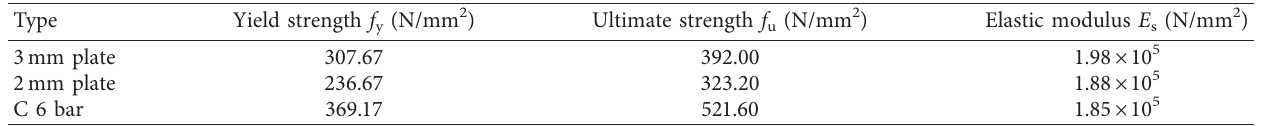
Figure 2: Steel frame and U-shaped connector. (a) Steel frame. (b) U-shaped connector. Table 1: Material properties of steel plate and bar.